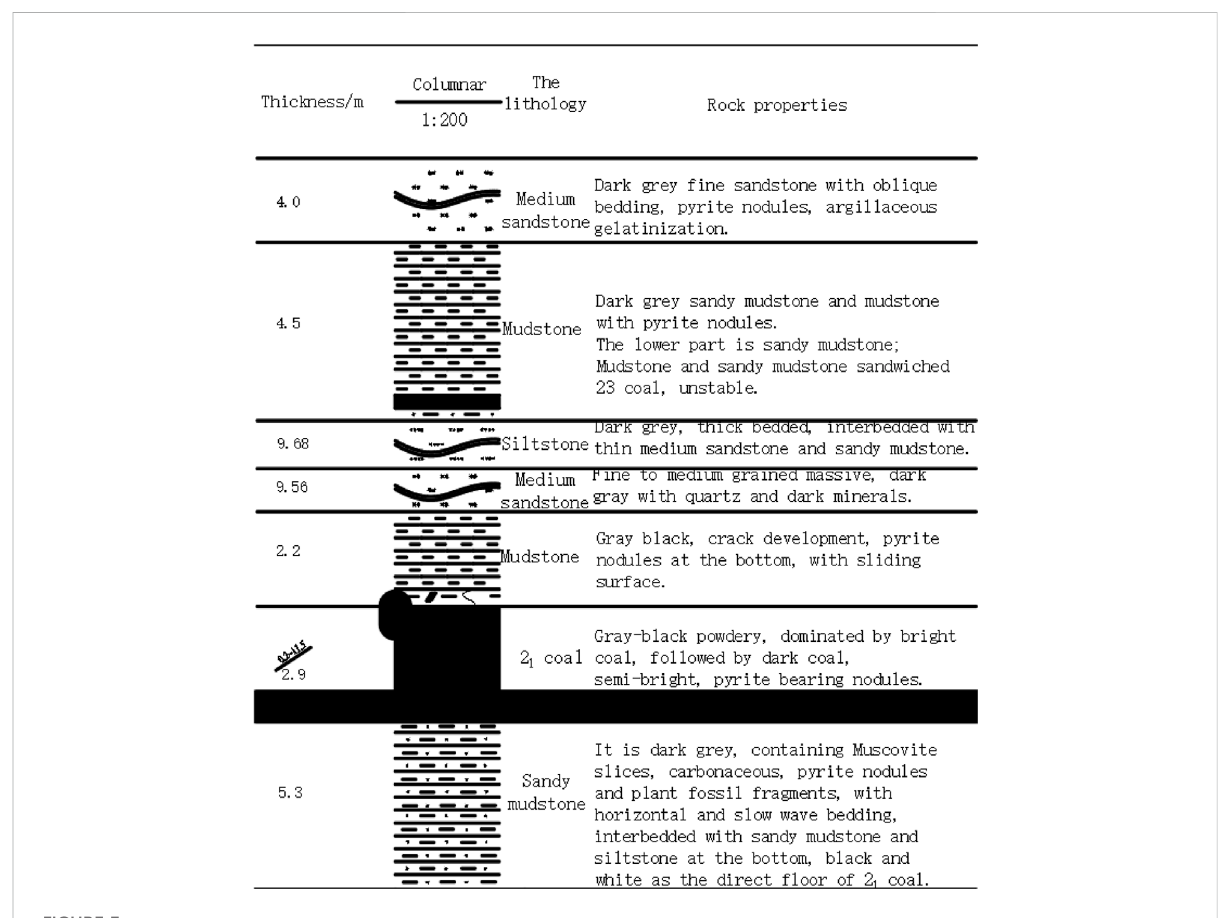
FIGURE 3 Strata histogram of Xin ’ an Coal Mine.